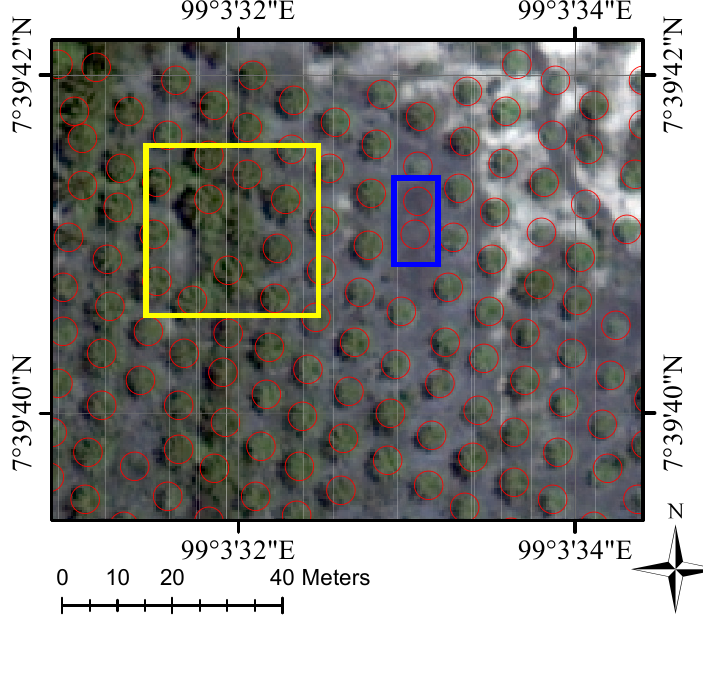
Figure 13. An example of false positive (yellow rectangle) and false negative (blue